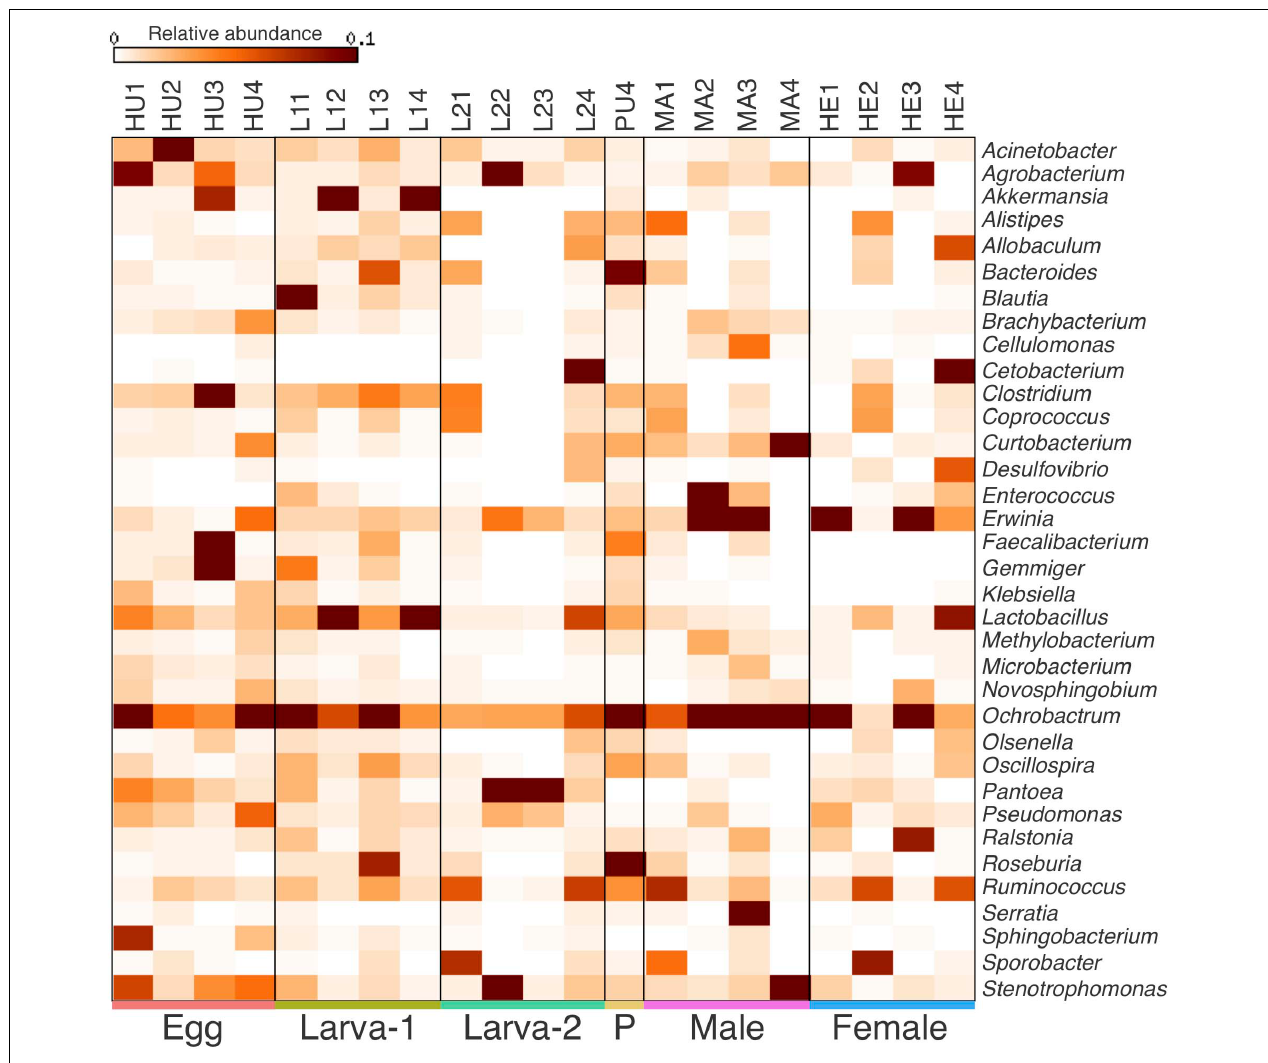
FIGURE 3 | Heatmap of the relative abundance for most prevalent bacterial genera (top 35) within the gut-associated microbiota of Hypothenemus hampei . Columns represent the biological replicates for egg (HU1–HU4), Larva-1 (L11–L14), Larva-2 (L21–L24), pupa (PU4), male (MA1–MA4), and female (HE1–HE4). Rows represent bacteria